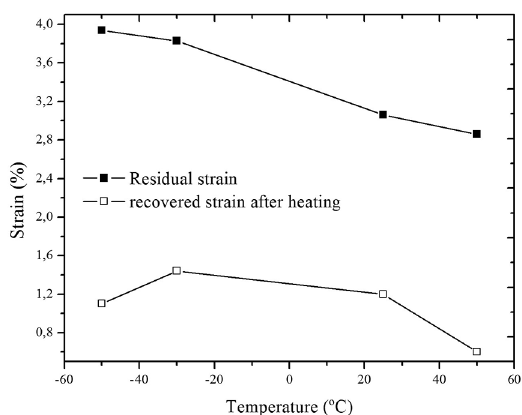
Figure 12. Residual strain and deformation recovered after heating as a function of temperature for Cu-11.8Al-0.6Be-0.5Nb (wt.%)